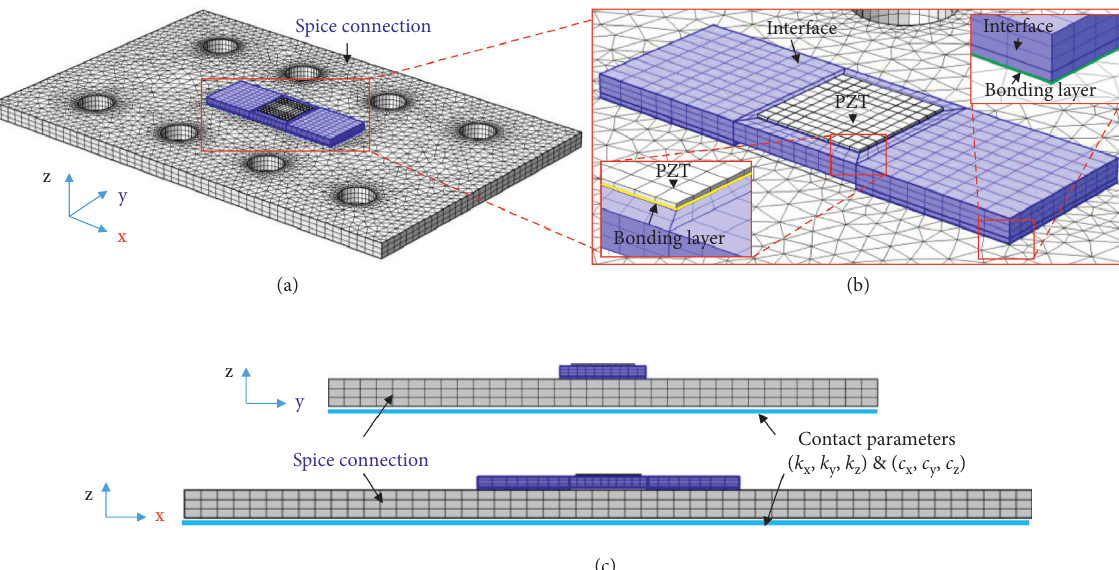
Figure 7: The FE modeling of the experimental model. (a) Meshed finite element model. (b) Smart interface and bonding layers. (c) Assigned contact parameters to simulate the effect of bolt